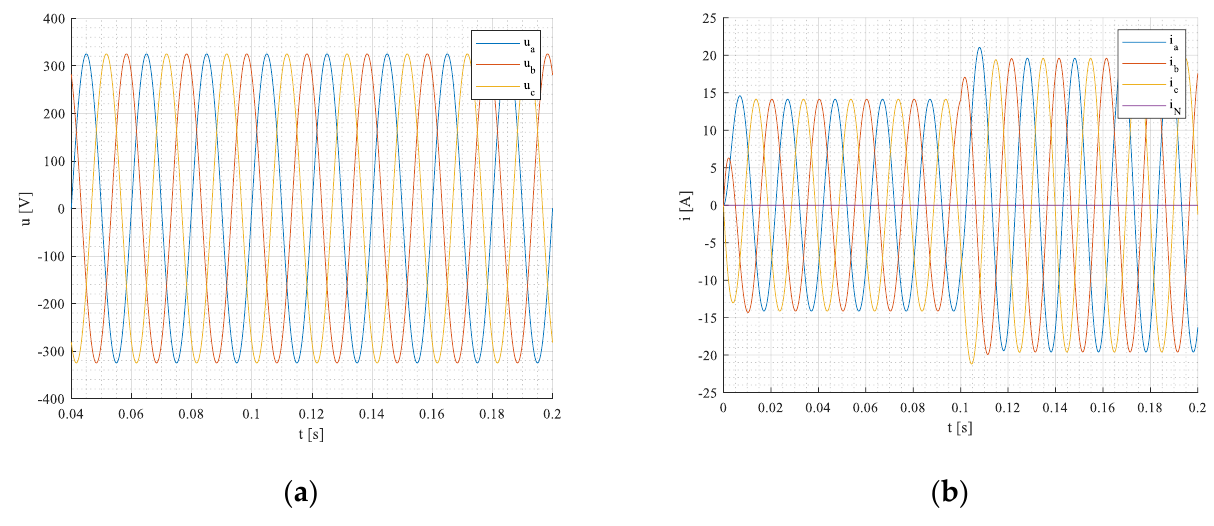
Table 5. IM motor parameters for steady-state before and after load change.